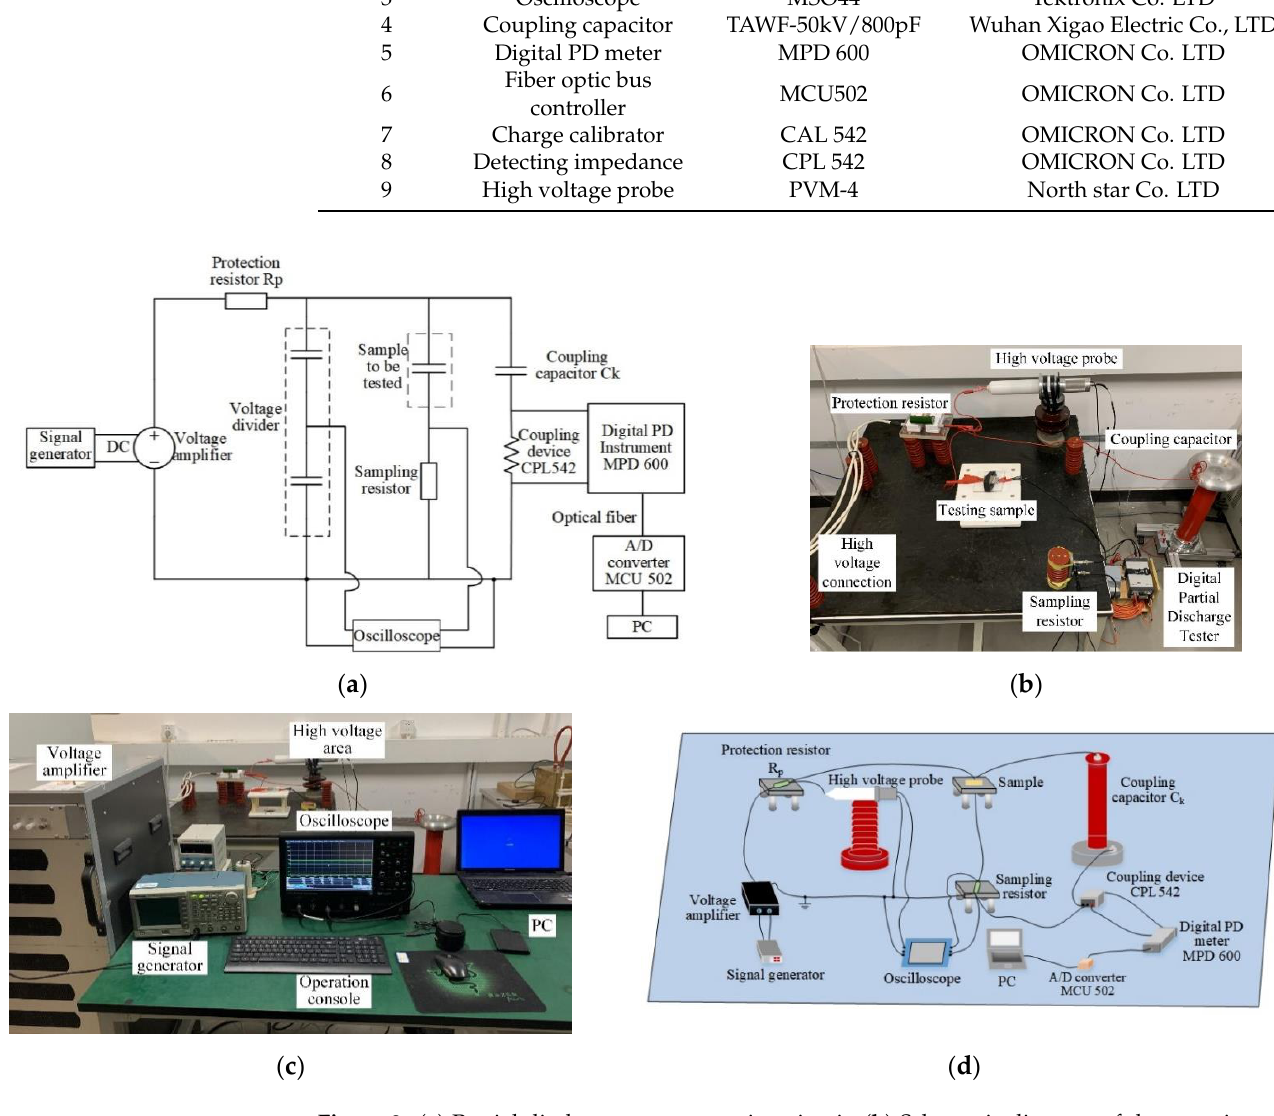
Figure 2. ( a ) Partial discharge test measuring circuit; ( b ) Schematic diagram of the experimental platform; ( c ) Schematic diagram of the construction of experimental circuit; ( d ) Schematic diagram of the experimental platform.